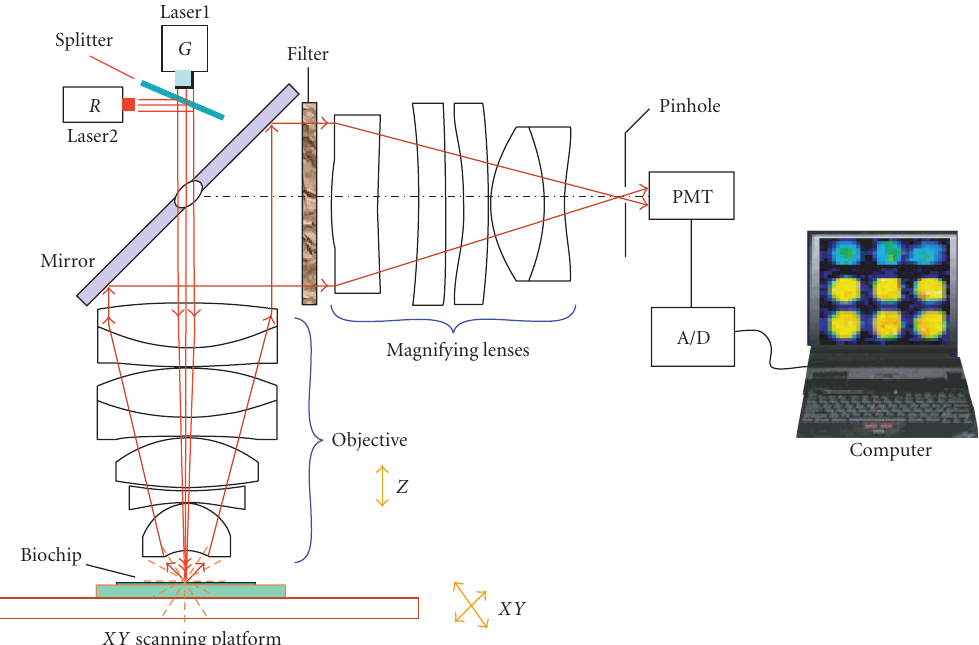
Figure 6: The newly developed confocal optical scanning system.